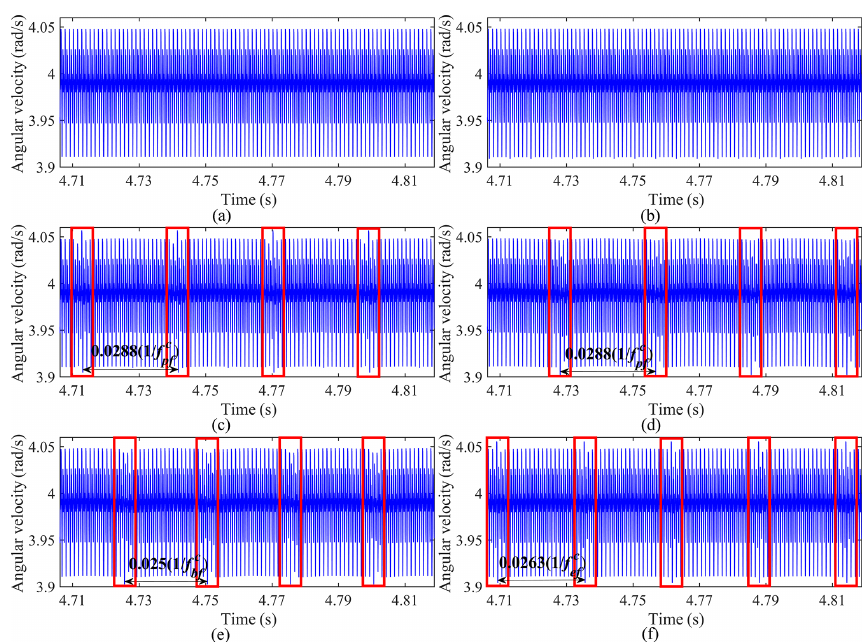
Figure 10. Ring gear e angular velocity signals: (a) healthy gear case, (b) failure case I, (c) failure case II, (d) failure case III, (e) failure case IV, and (f) failure case